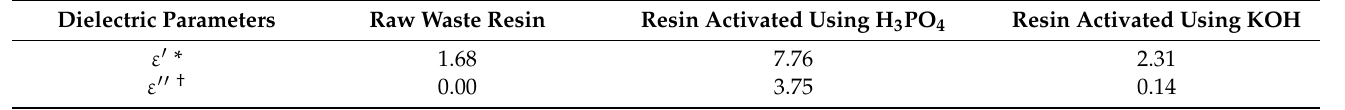
Table 3. Dielectric properties of phenolic resin waste and waste treated with activators. Dielectric Parameters Raw Waste